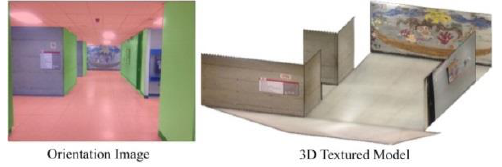
Figure 1. From left to right: ground truth orientation image and the respective 3D textured